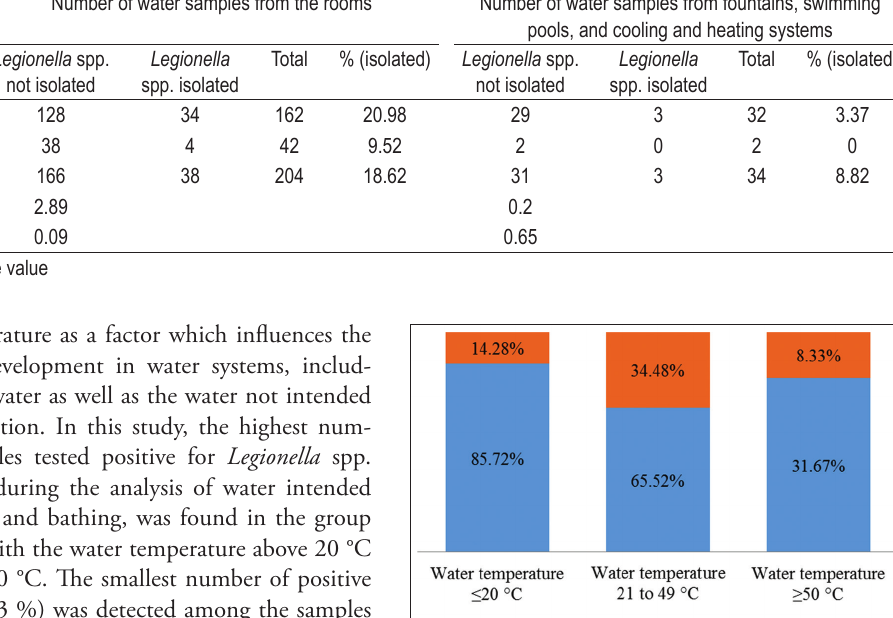
TABLE 3. Comparison results of the X 2 test and the difference in the number of positive and negative results among samples with different concentrations of free residual chlorine Cl (mg/L) Number of water samples from the rooms Number of water samples from fountains, swimming 2 Legionella spp.